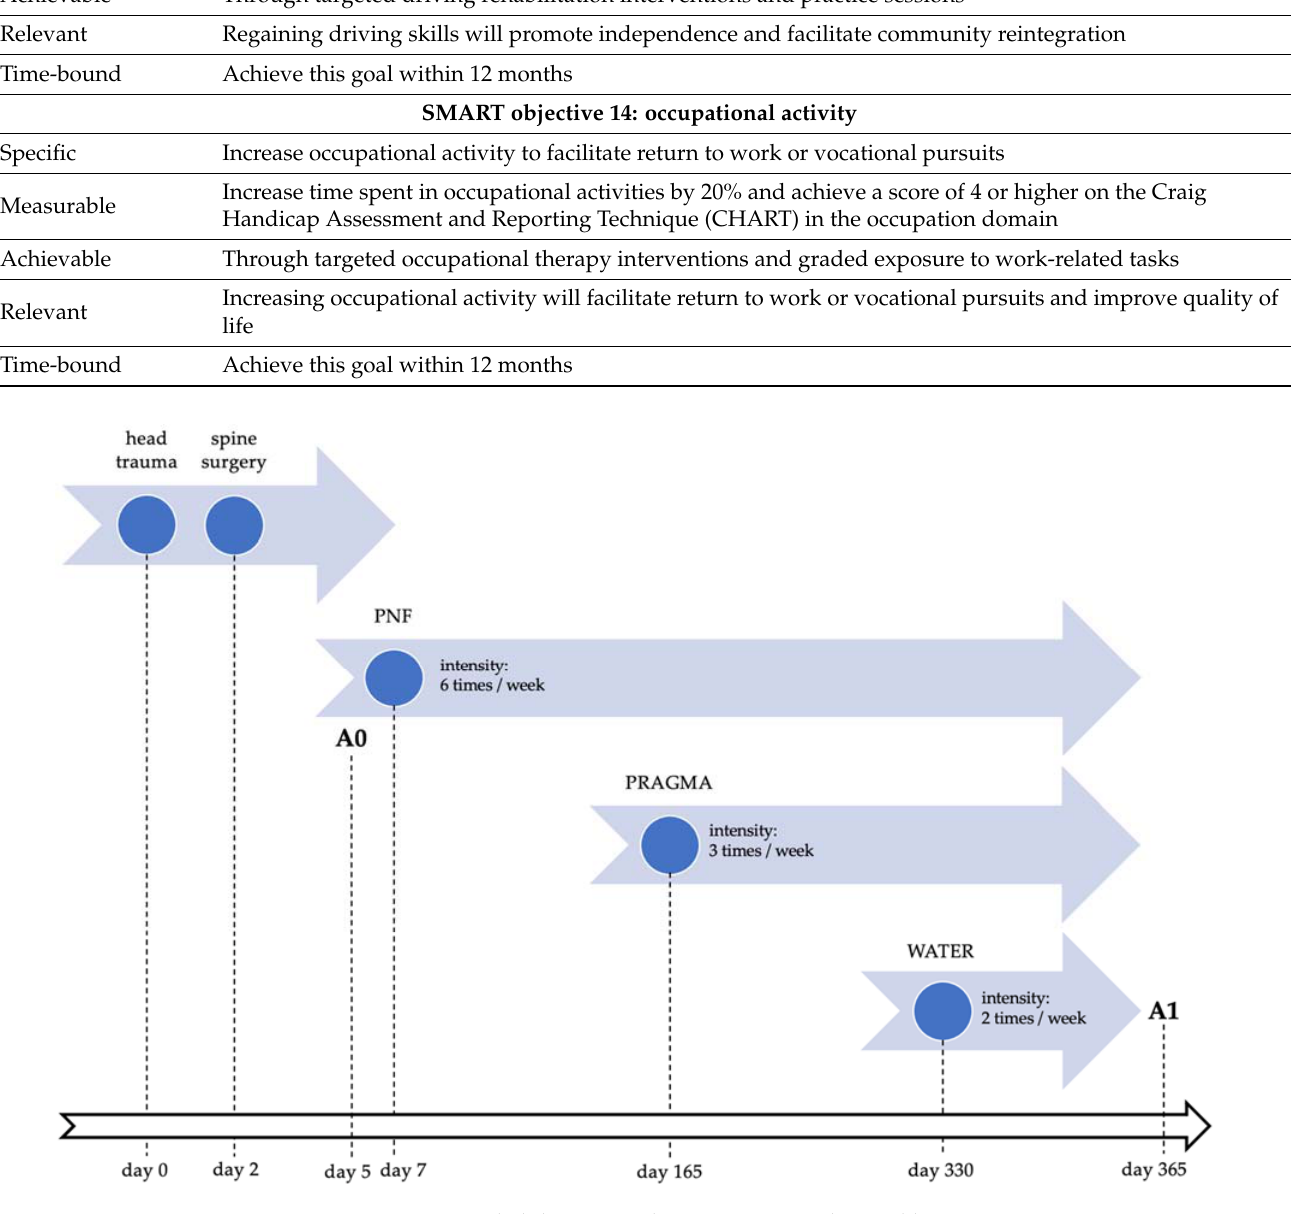
Figure 1. Neurorehabilitation and assessment timeline. Abbreviations: PNF, proprioceptive neuromuscular facilitation; PRAGMA, physical therapy using PRAGMA Pro device; WATER, water rehabilitation; A0, baseline assessment; A1, control assessment.